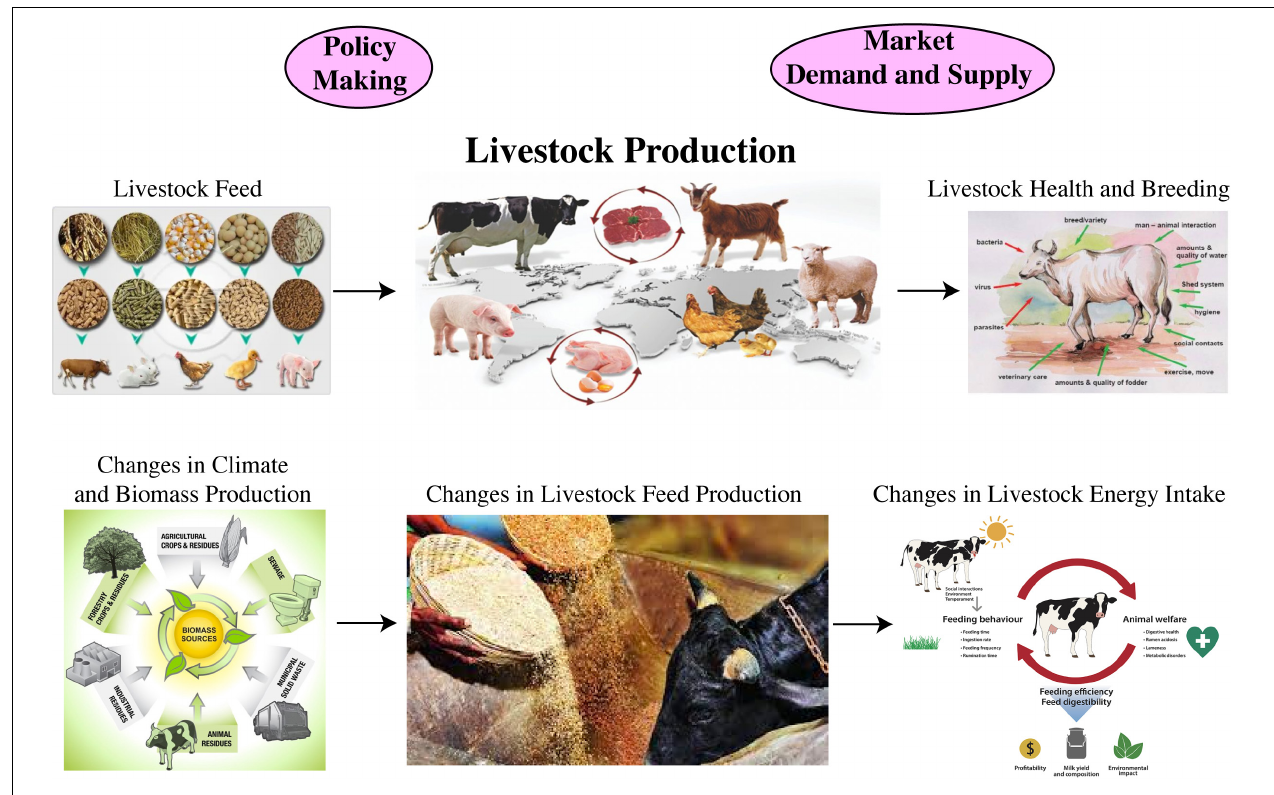
FIGURE 3 | Impacts of climatic variabilities on livestock production including policy makings and market demand and